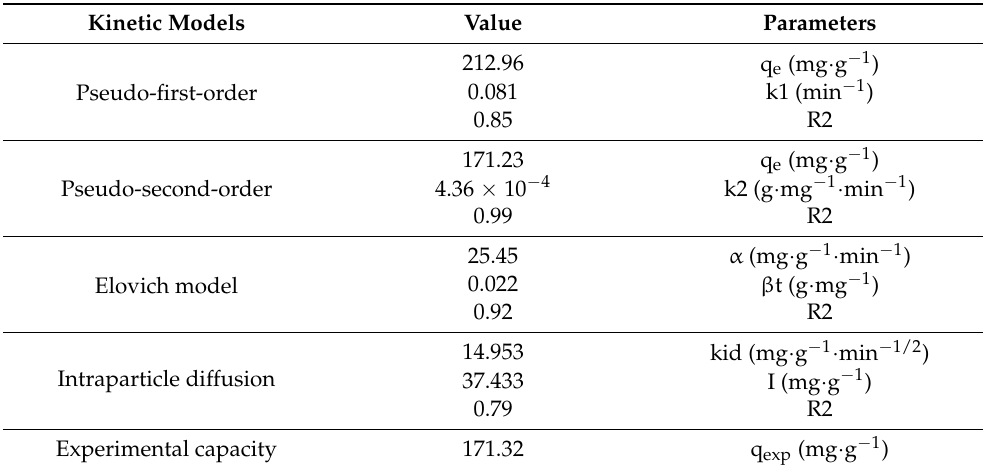
Table 2. Kinetic models for Y(III) adsorbed on the AHIBC